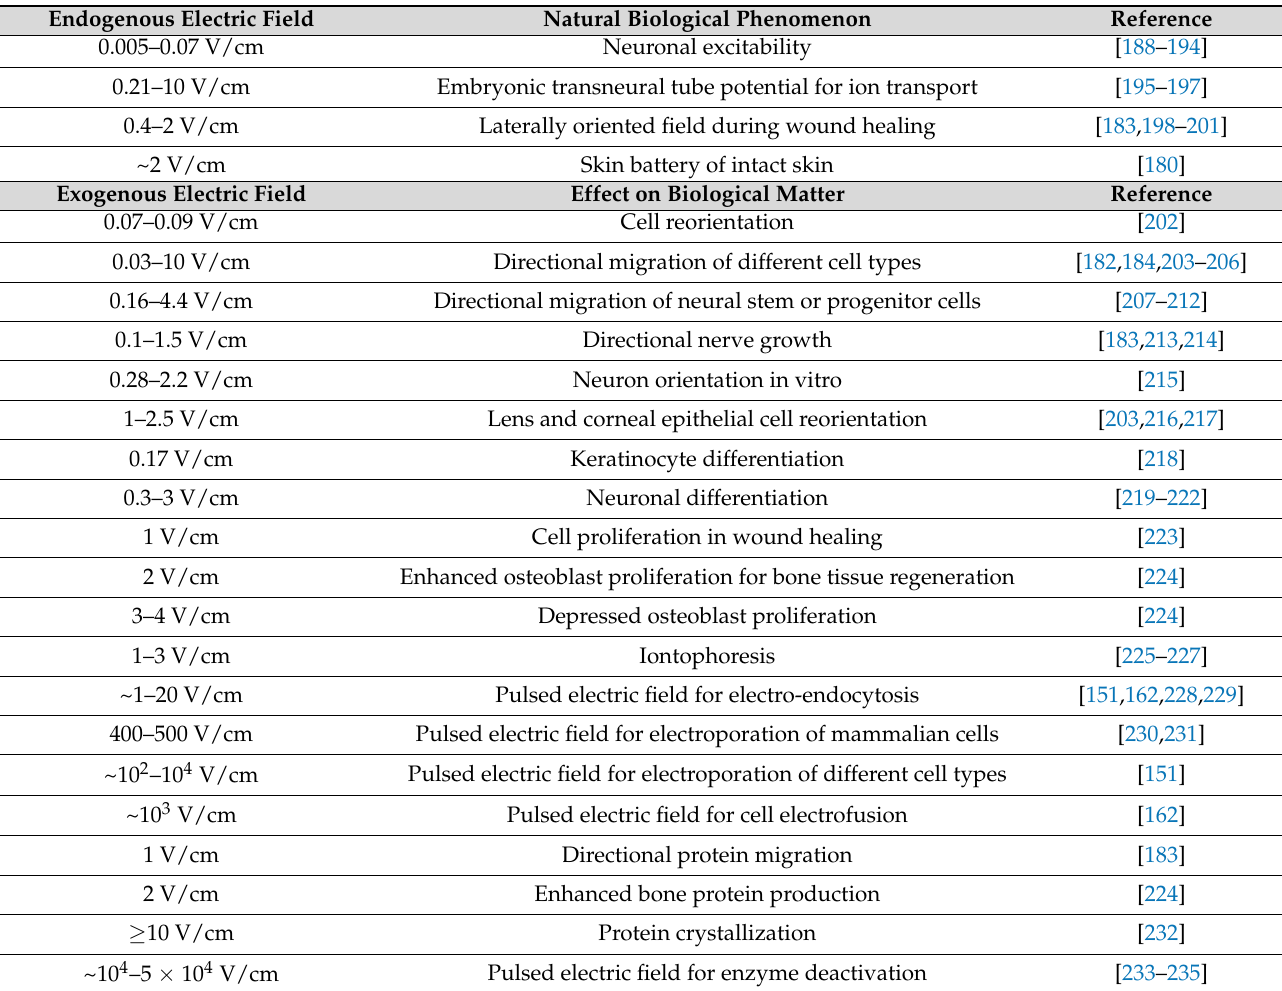
Table 1. Typical values and ranges of the electric field strength naturally present in biological matter or required to induce a certain biological